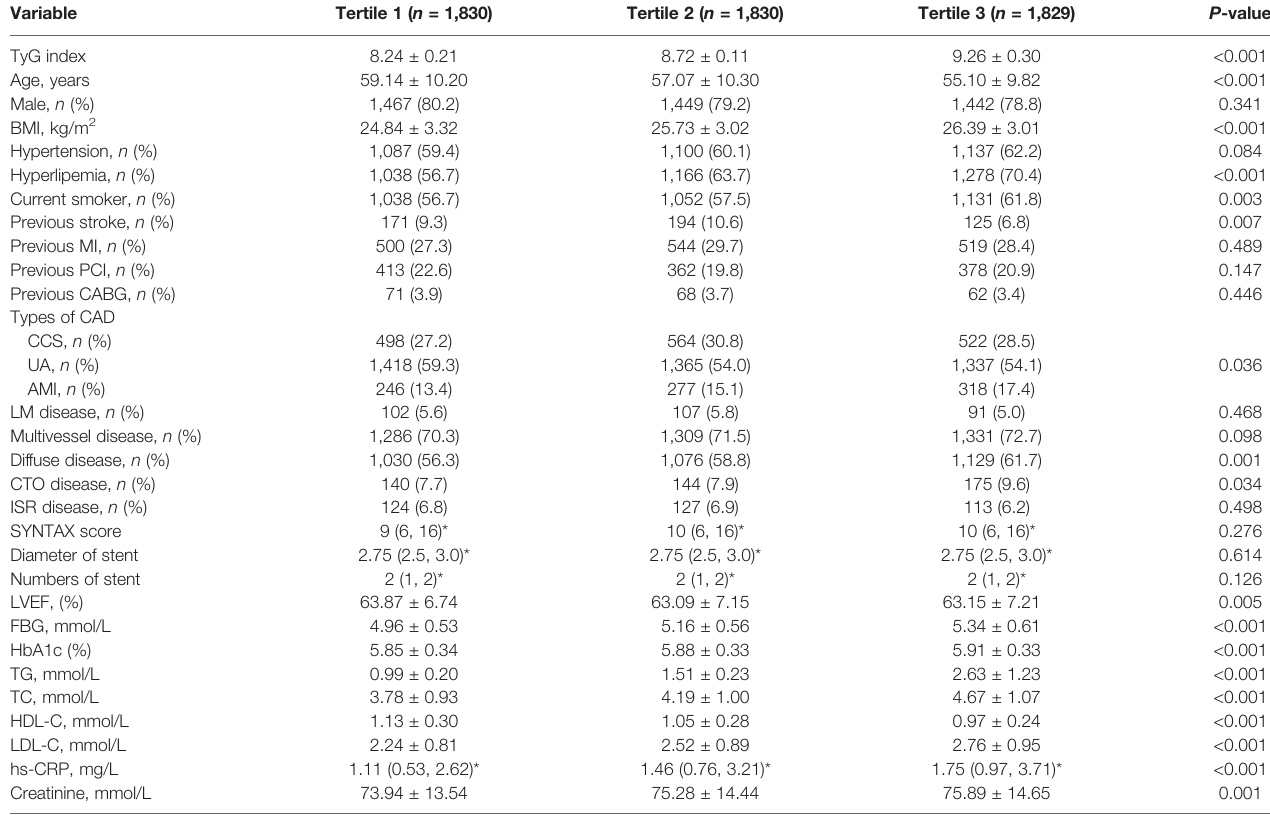
TABLE 1 | Baseline demographic and clinical data of the three groups.